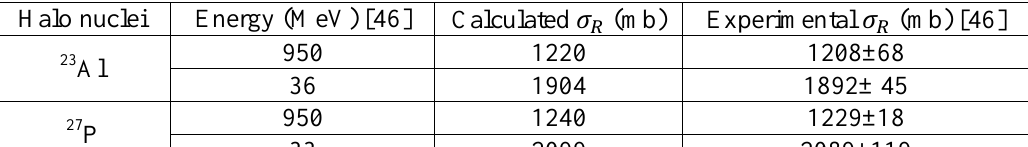
for 23 Al+ 12 C and 27 P+ 12 C systems. 𝝈 𝑹